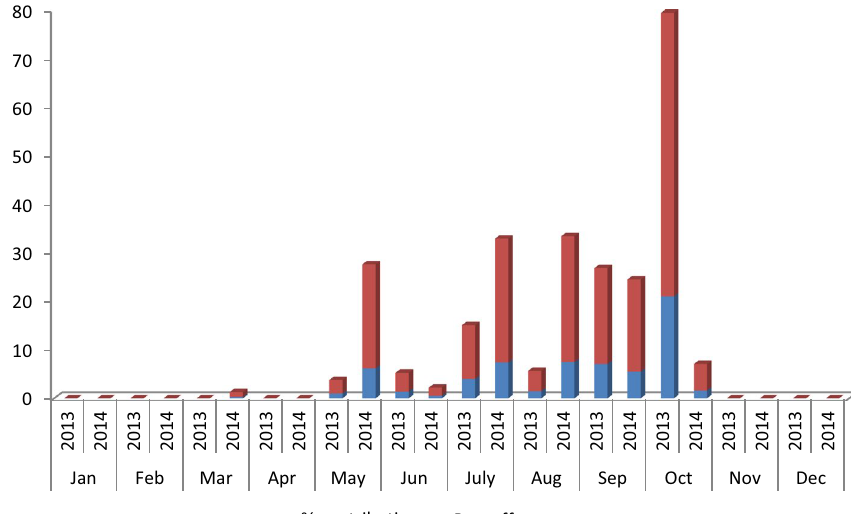
Fig. 2 Total run-off and % con-